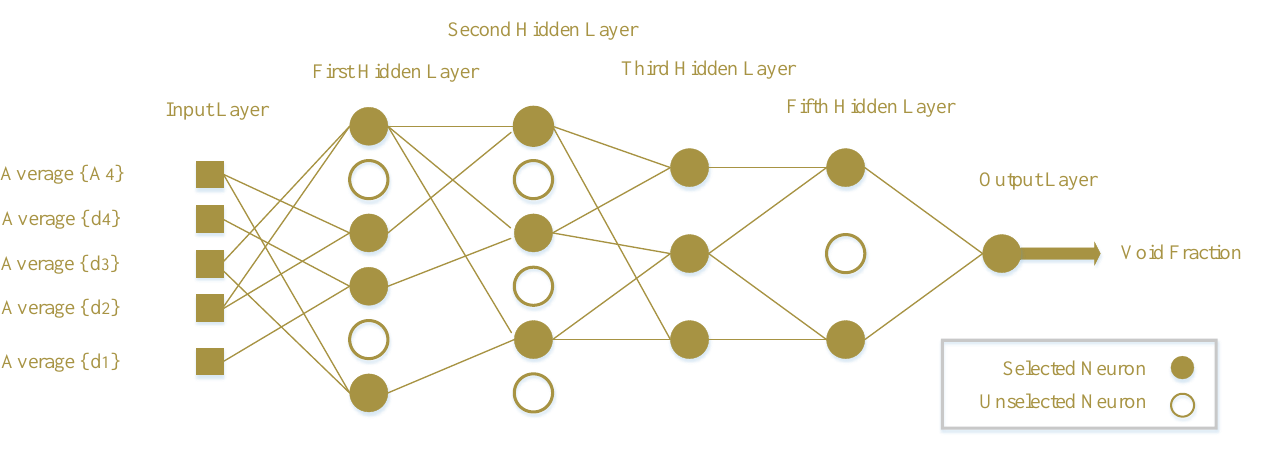
Figure 6. The structure of designed network. Table 1. Calculated errors.